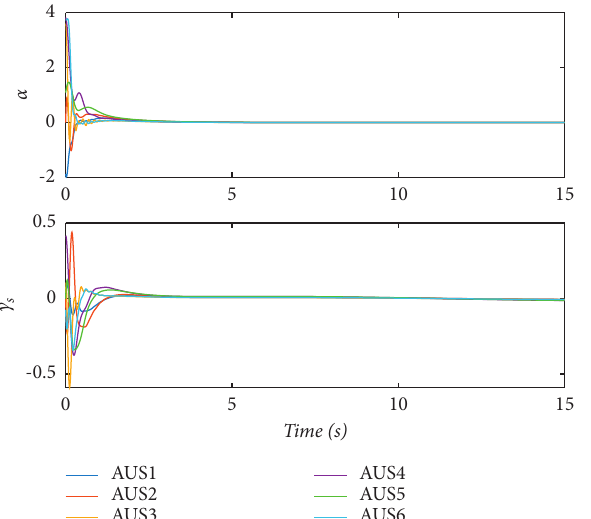
Figure 6: Trajectories of the angle of attack and the heeling angle of CAUS.